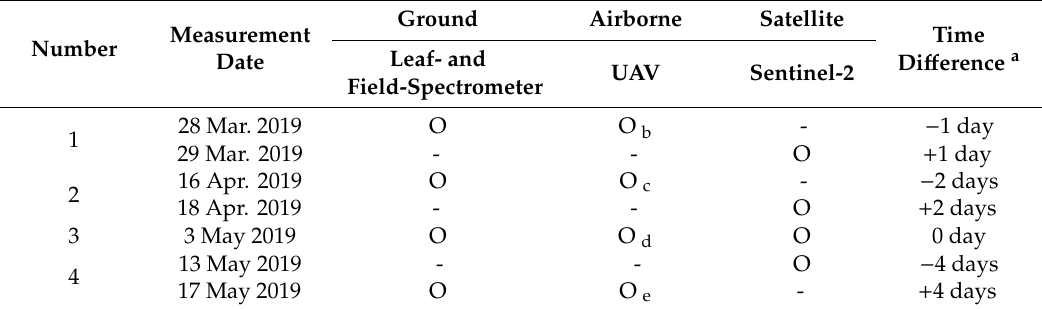
Table 1. Measurement information for ground-, unmanned aerial vehicle (UAV-), and satellite-based remote sensing